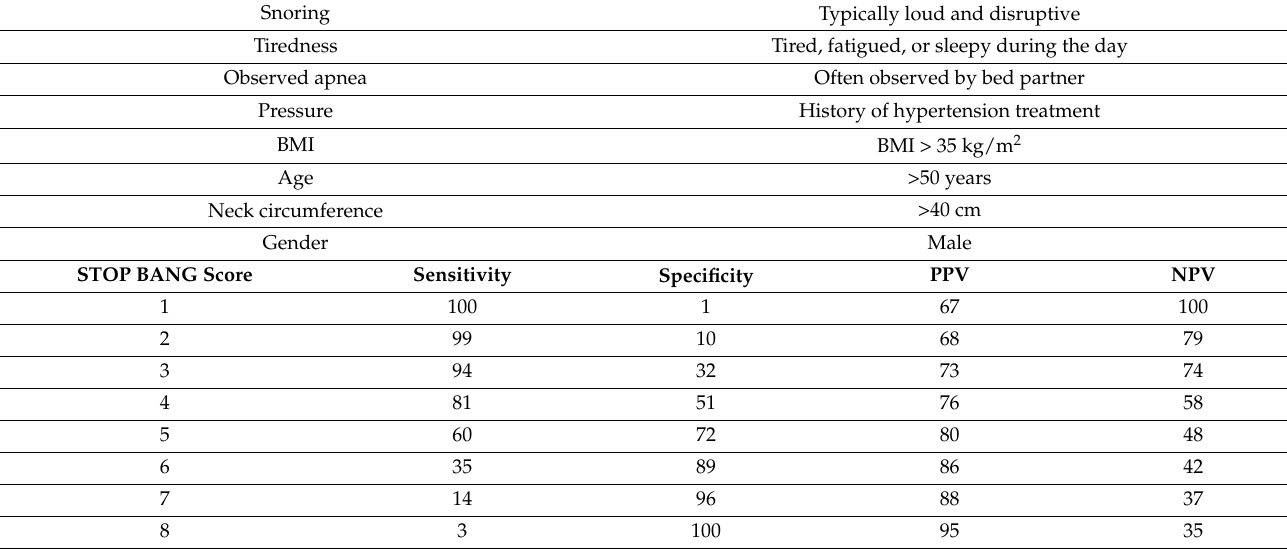
Table 1. The STOP-BANG questionnaire and its accuracy in detecting moderate or severe sleep apnea (AHI ≥ 15/hour). Score one point for each